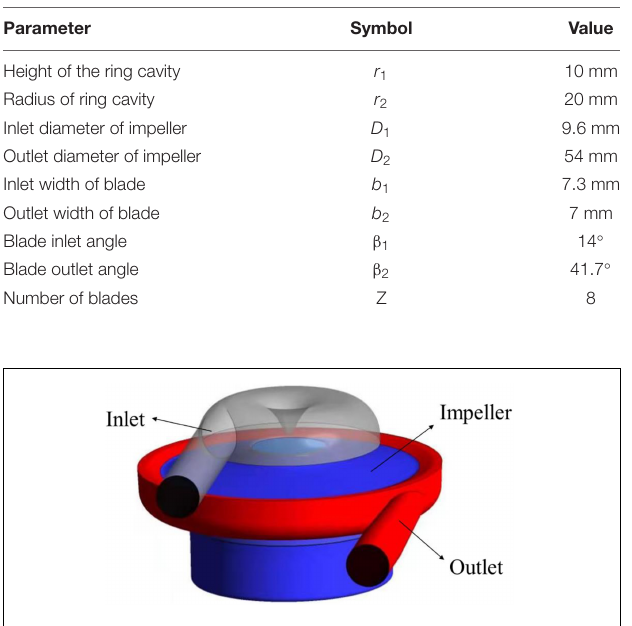
TABLE 1 | Parameters of the portable blood pump.